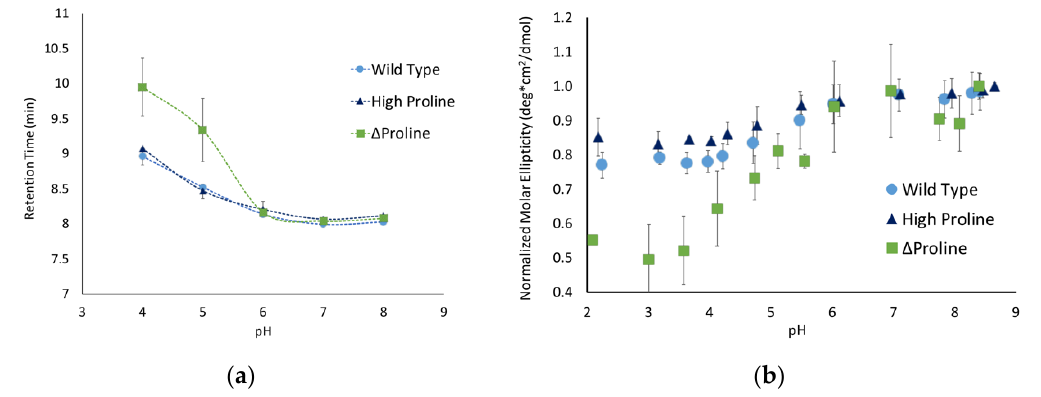
Figure 5. Effects of proline on pH sensitivity as observed with ( a ) size-exclusion chromatography and ( b ) circular dichroism. Circular dichroism values at 200 nm were taken and normalized to the highest pH point for the peptide.